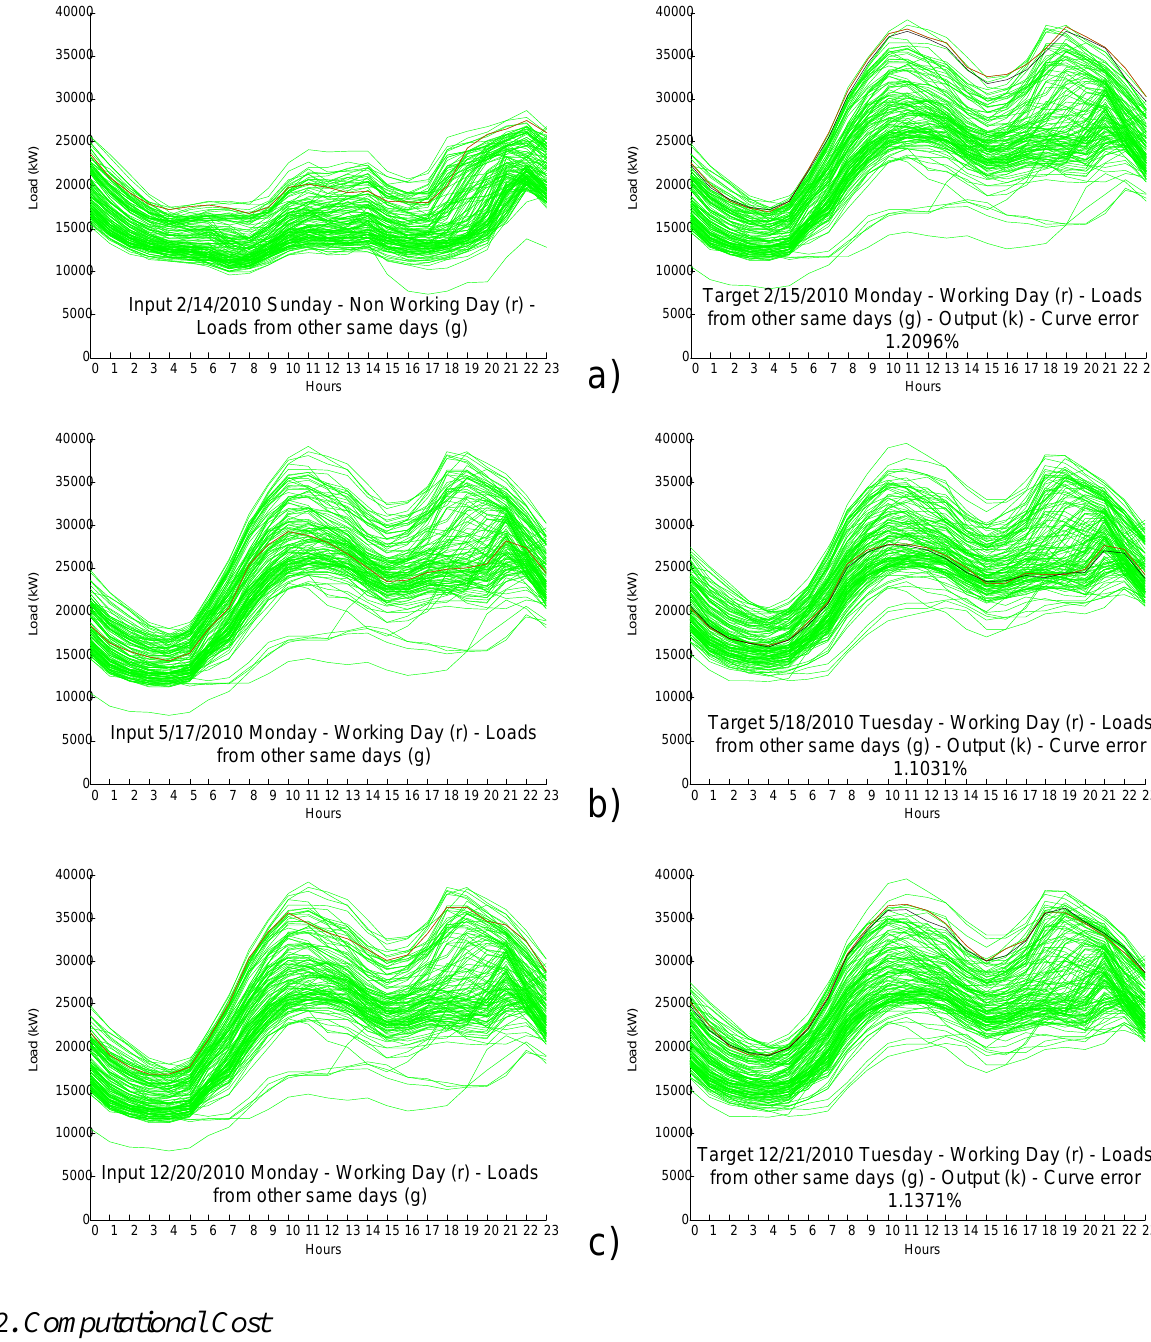
Figure 11. Forecasts with low mean error: ( a ) 2/15/2010; ( b ) 5/18/2010; ( c )